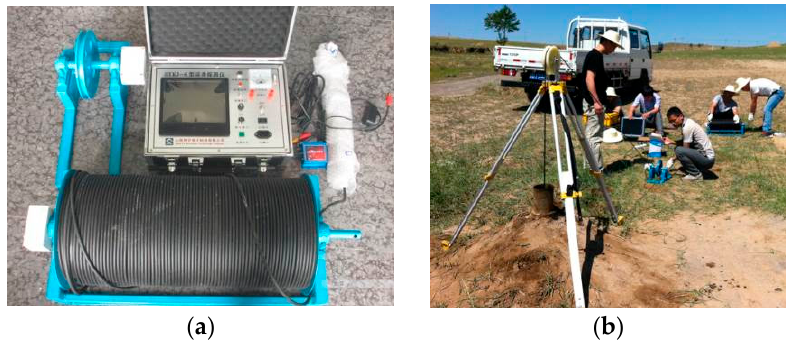
Figure 4. Borehole TV and field observation of surface borehole deformation. ( a ) Borehole TV; ( b ) Field test photo.